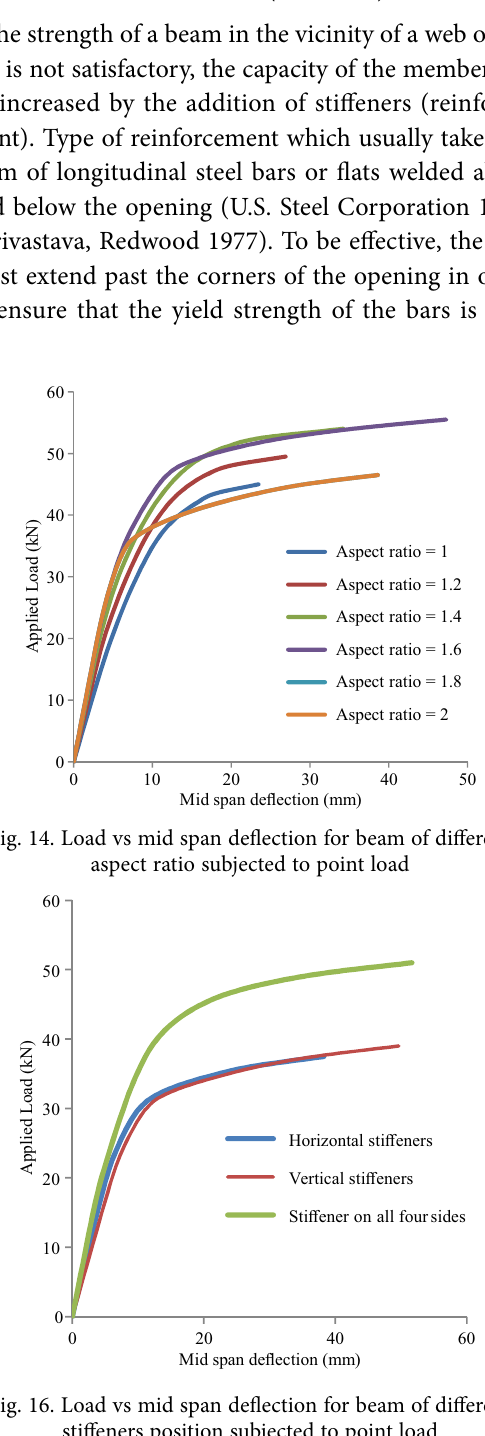
Fig. 17. Load vs mid span deflection for beam of different stiffeners position subjected to uniformly distributed